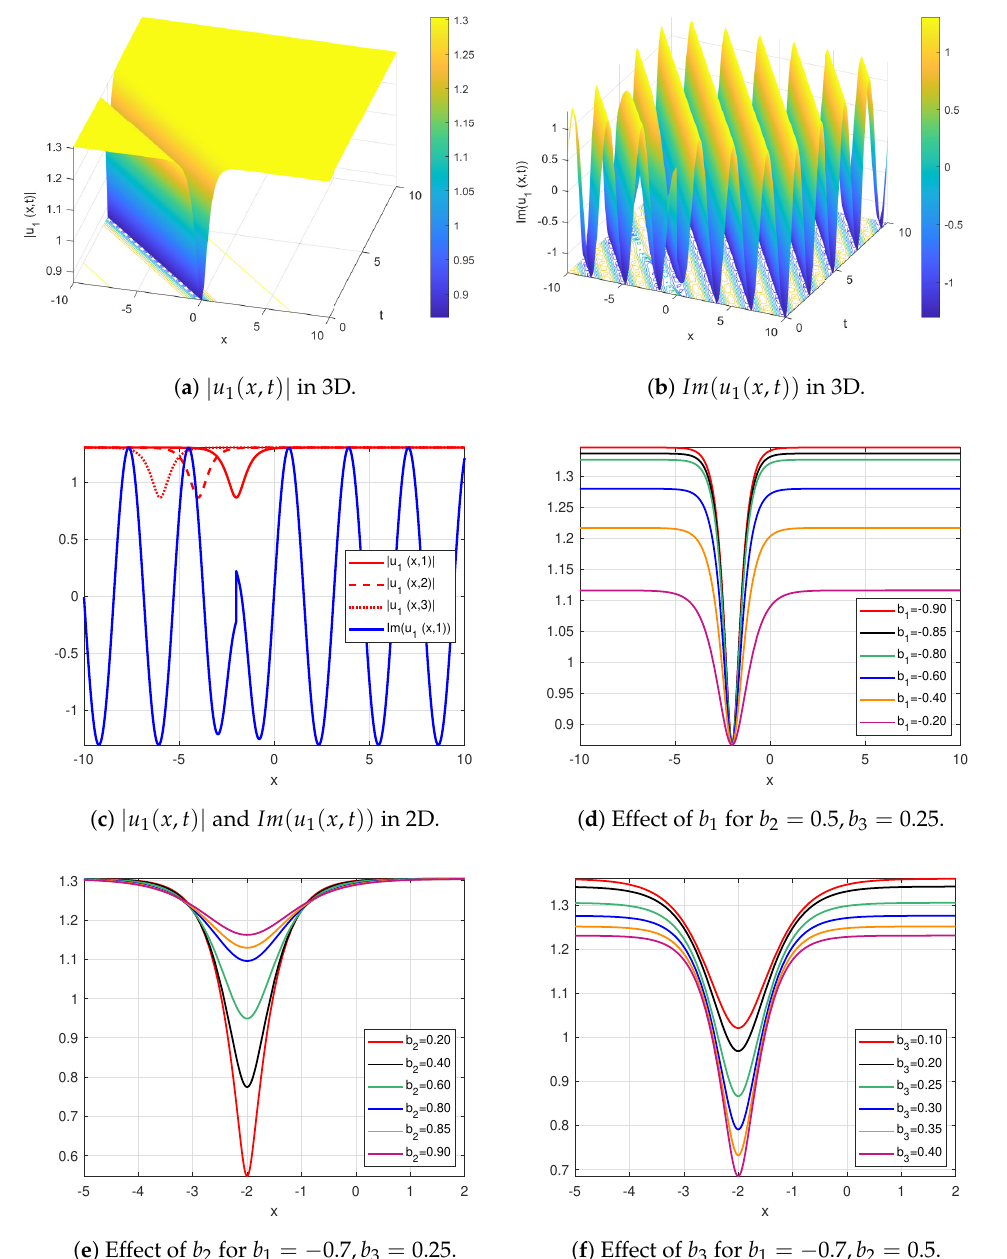
Figure 1. The various illustrations of u 1 ( x , t ) in Equation (19) by combination of the Set 1 in Equation (12) and the selected h = − 0.04, a = 0.5, φ 0 = 0.5, b 1 = − 0.7, b 2 = 0.5, b 3 = 0.25, κ = 2 values. Figure 2 visualizes the peak soliton character and also the effect of the anti-cubic pa- rameters on this soliton for the obtained optical soliton solution of u 5 ( x , t ) in Equation (23), with the Set 2 in Equation (13) and the selected parameters h = − 0.04, a = − 0.5, φ 0 = 0.5, b 1 = − 0.7, b 2 = 0.5, b 3 = 0.25, κ = 2. It is observed from Figure 2a,c (red lines) that the soliton has the anti-peaked shape and travels to the right for the specific time t = 1, 2, 3 . At the same time, there is a vertical amplitude (level) difference between the left and right skirts (wings) of the soliton. Figure 2b,c (blue line) belong to Im ( u 5 ( x , t )) and they reflect periodic solutions in different amplitudes. Figure 2d, depicts the effect of b 1 with the selected values − 0.90, − 0.85, − 0.80, − 0.60, − 0.40 and − 0.20, respectively (colors from red to violet), when b 2 = 0.5, b 3 = 0.25. If we examine Figure 2d when b 1 takes the